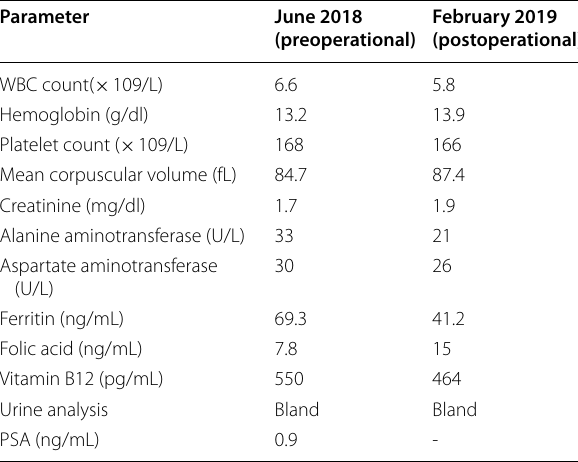
Table 1 The patient’s pre- and postoperative laboratory values